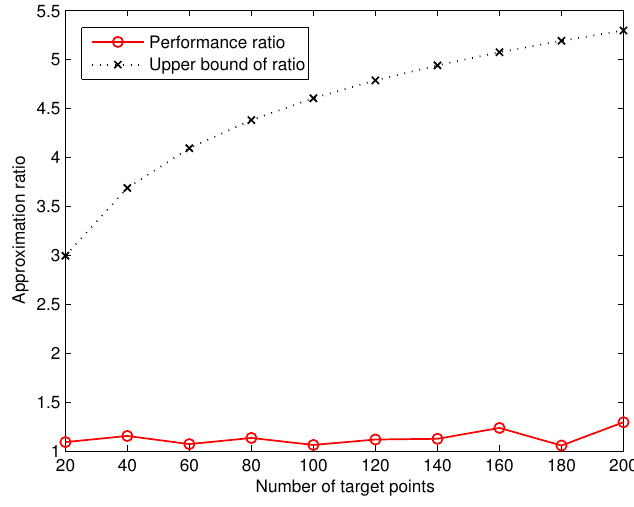
Figure 6. Measured average approximation ratio of GreedyDLDT for DLDT in response to a varying number of target